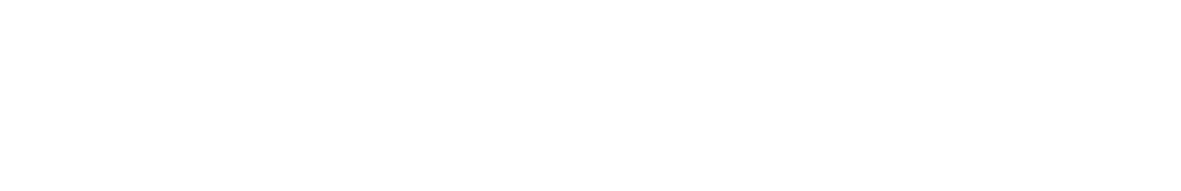
Frontiers in Cell and Developmental Biology |